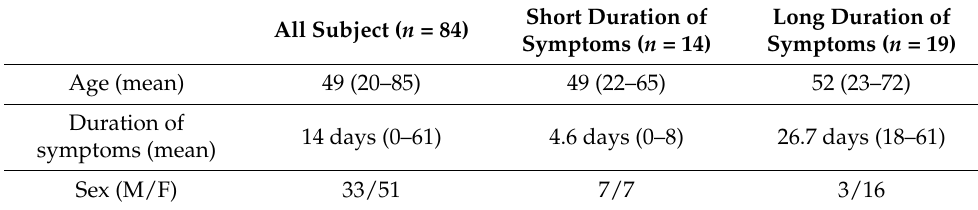
Figure 1. Study design and patient characteristics. ( A ) Schematic representation of the subject selection criteria used in this study and the timing of sample collection. ( B ) Analysis of the relationship between subject age and the duration of self-reported COVID-19 symptoms in all subjects included in this analysis. Asymptomatic SARS-CoV-2 PCR+ individuals were assigned 0 days of symptoms. Filled circles indicate subjects included in the short duration of symptoms group. Empty circles indicate individuals included in the long duration of symptoms group. r 2 and p value calculated by 2-tailed Pearson Correlation test. Table 1. Convalescent COVID-19 patient